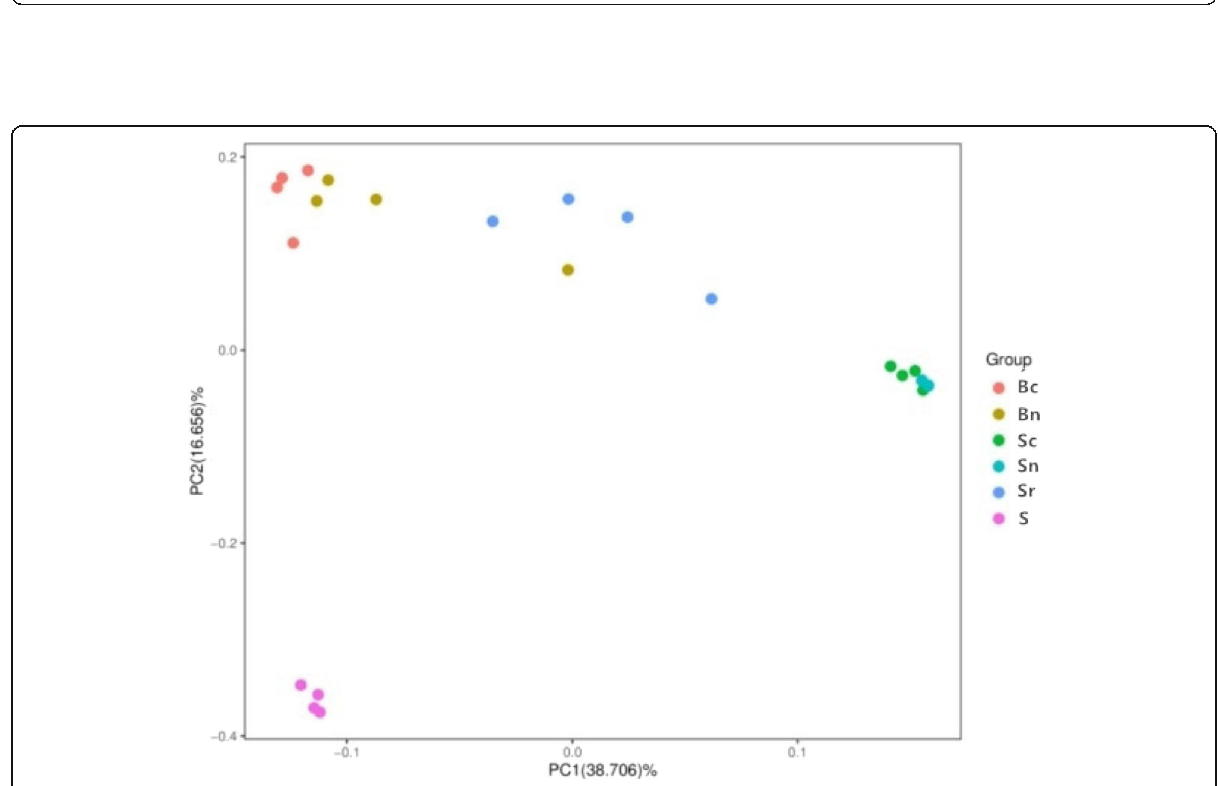
Fig. 2 Beta diversity differences of all sugar beet and soil samples. Bc: sugar beet tuber of continuous cropping; Bn:sugar beet tuber of non- continuous cropping; Sc: soil of Bc; Sn: soil of Bn; Sr: rhizosphere soil of Bn; S: seeds of sugar